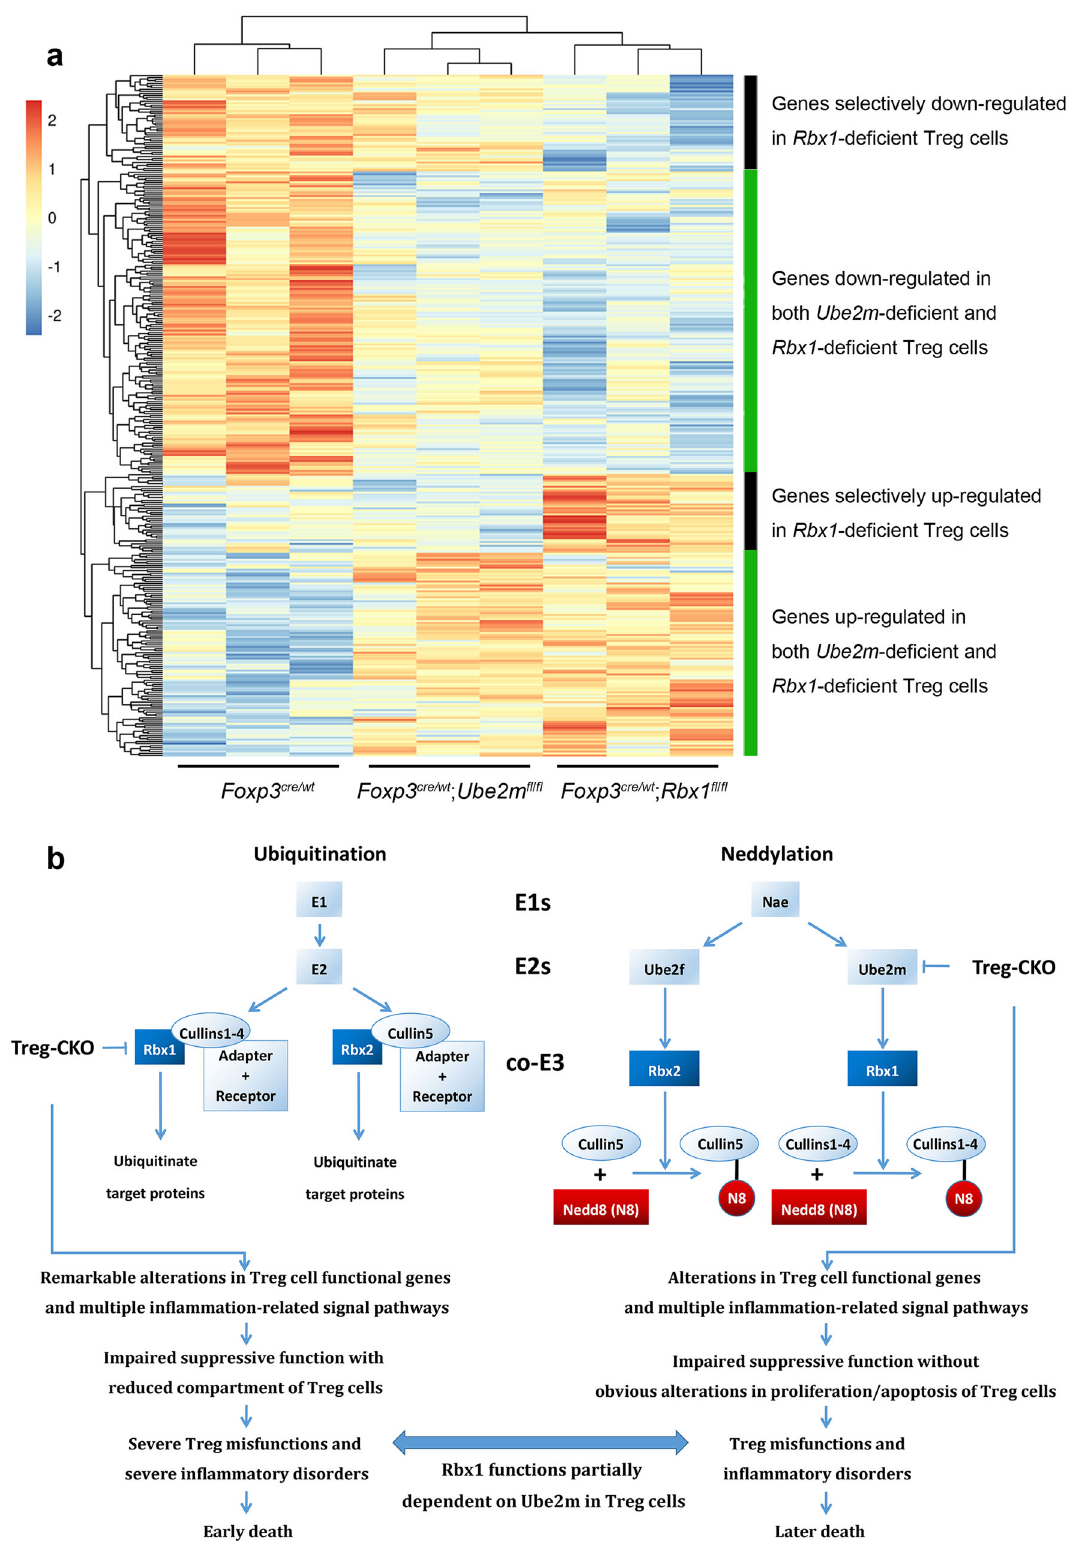
Fig. 9 Rbx1 acts via Ube2m-dependent and -independent mechanisms in Treg cells. a Unbiased cluster analysis of the transcriptional programs revealed four categories of genes differentially expression in Rbx1 - and Ube2m -de fi cient Treg cells, as compared to the wt control Treg cells. b Working model of Rbx1 and Ube2m in functional regulation of Treg cells. The Treg speci fi c Rbx1 deletion causes the alterations in Treg functional genes, and multiple in fl ammatory and signaling, leading to early-onset immune disorder and death, whereas Ube2m deletion in Treg cells also caused altered in fl ammatory signaling pathway with much less extent, and death at the later stage. Lack of phenotype by deletion of Rbx2/Sag or Ube2f in Treg cells excludes the possible involvement of CRL5 in Treg